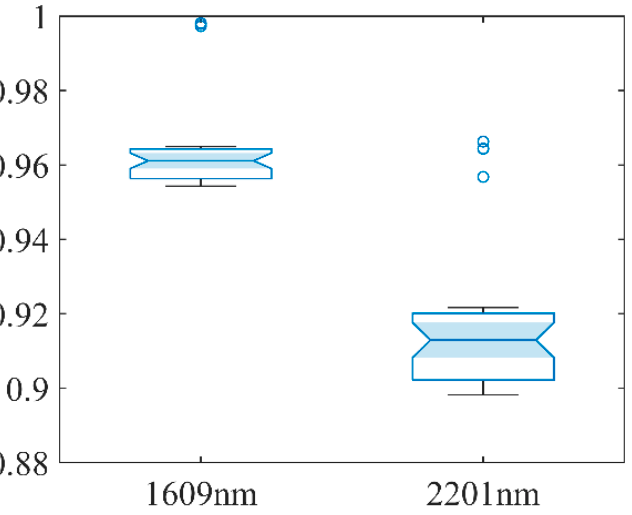
Figure 14. Variations in the transmittance ( t ) in SWIR bands (based on cloudless images from 2013 to 2018, a total of 36